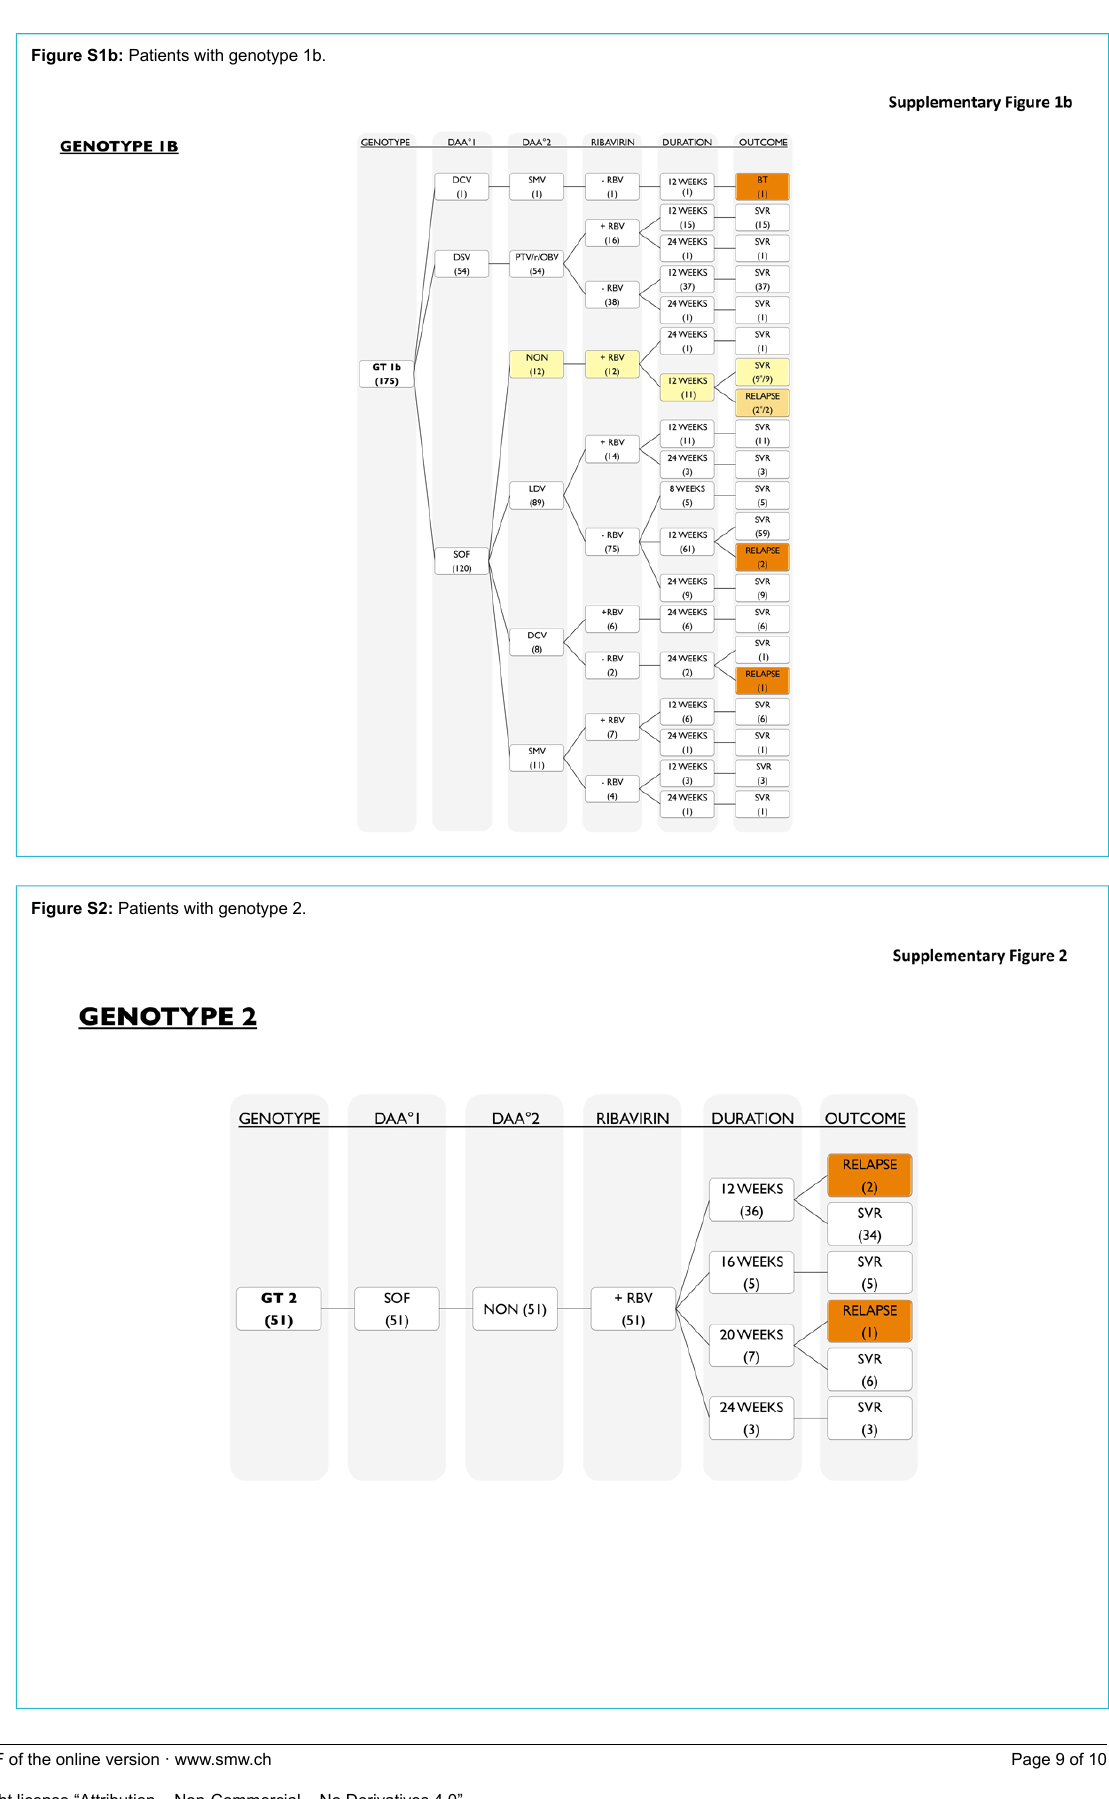
Figure S1b: Patients with genotype 1b.